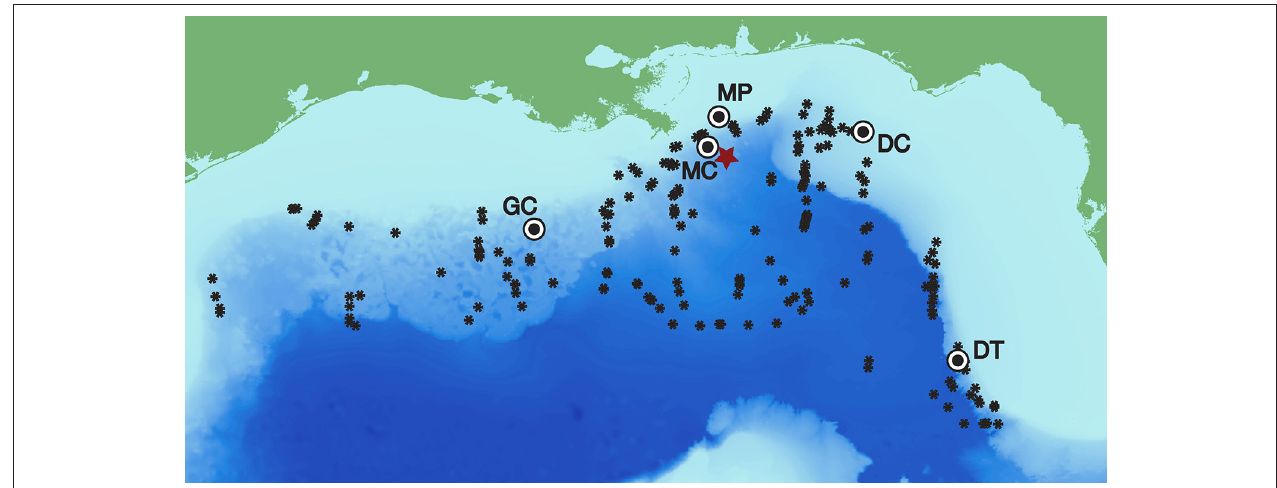
FIGURE 1 | Long-term recording sites in the Gulf of Mexico with Kogia spp. click detections (Mississippi Canyon - MC 28-50.8N 88-27.9W 980m, Green Canyon - GC 27-33.4N 91-10.0W 1100m, and Dry Tortugas - DT 25-31.9N 84-38.2W 1,300m) and those without (Main Pass–MP and DeSoto Canyon–DC). The Deepwater Horizon site is designated with a red star, and Kogia spp. visual sightings are given by black asterisks (following Waring et al., 2013).